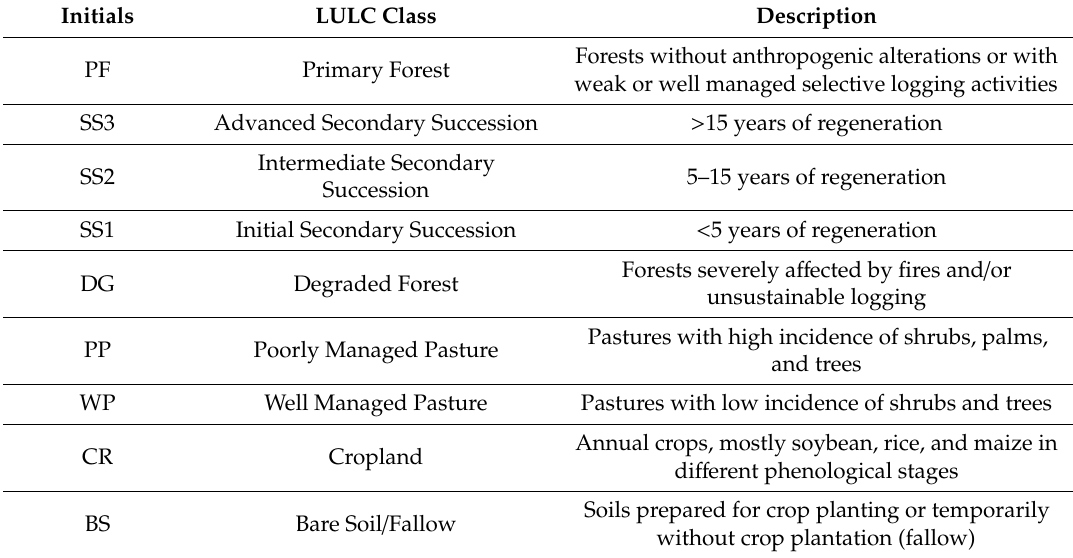
Table 1. Description of representative land use and land cover (LULC) classes found in the study